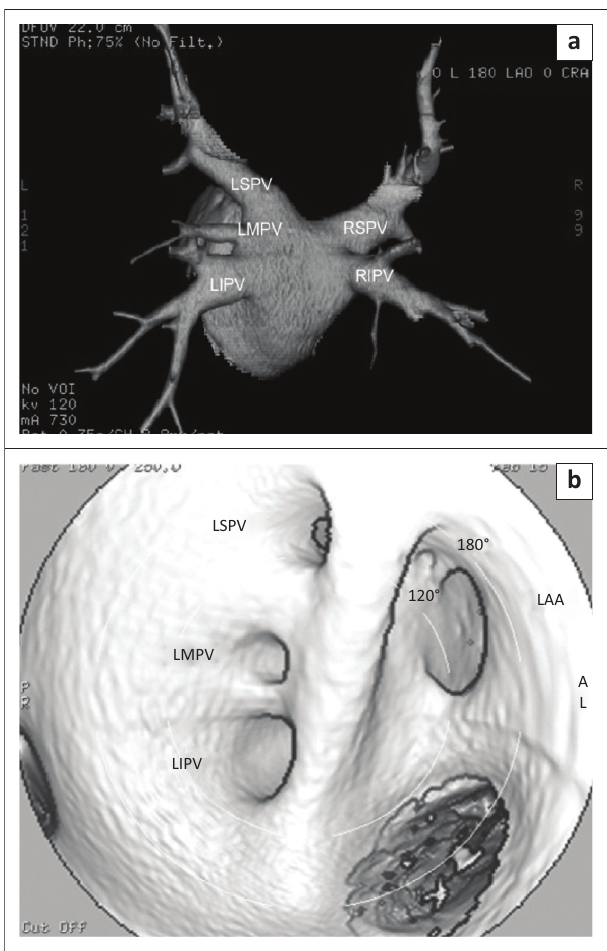
LSPV, left superior pulmonary vein; LIPV, left inferior pulmonary vein; RSPV, superior segment right inferior pulmonary vein; RIPV, right inferior pulmonary vein; LMPV, left middle pulmonary vein; LAA, left atrium appendage. FIGURE 5: Supernumerary vein in a 52-year-old man with atrial fibrillation, with a left middle pulmonary vein draining the lingula directly into the left atrium: (a) Three-dimensional model of the left atrium and pulmonary veins, which shows the left superior pulmonary vein (LSPV), left accessory pulmonary vein draining the lingula directly to the left atrium. This is equivalent to an accessory middle lobe vein on the right. This is labelled as the left middle pulmonary vein (LMPV). Left inferior pulmonary vein (LIPV), right superior pulmonary vein (RSPV) and right inferior pulmonary vein (RIPV); (b) The left atrial endocardial view which shows the left superior pulmonary vein ostium (LSPV), left middle pulmonary vein ostium (LMPV), left inferior pulmonary vein ostium (LIPV) and left atrium appendage (LAA).